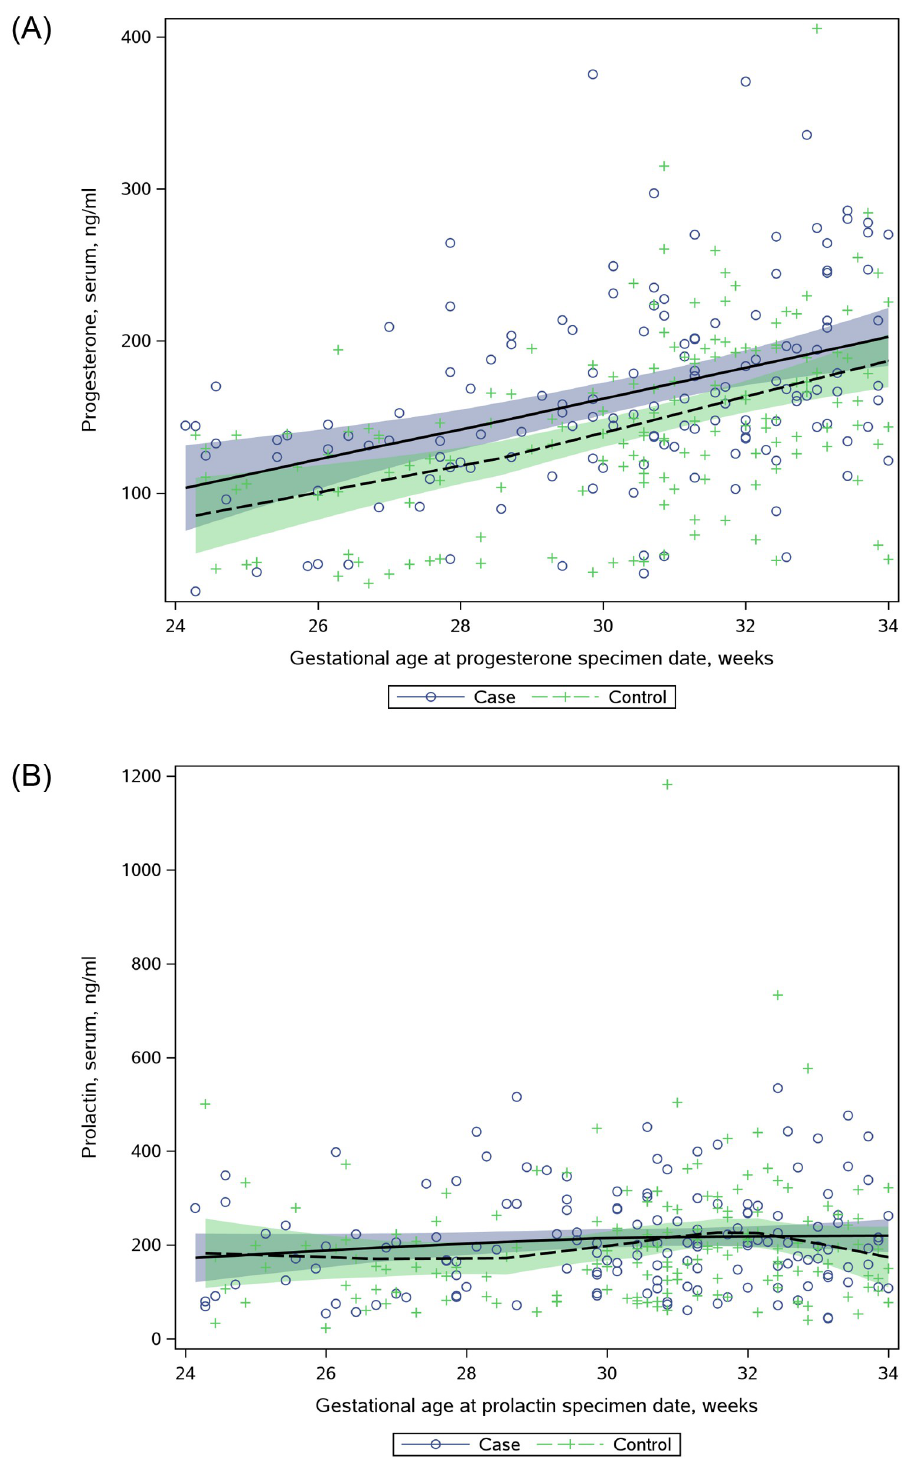
Fig 1. Concentrations of progesterone (A) and prolactin (B) by gestational age at specimen collection. Cases (+) and controls (o) are noted separately.